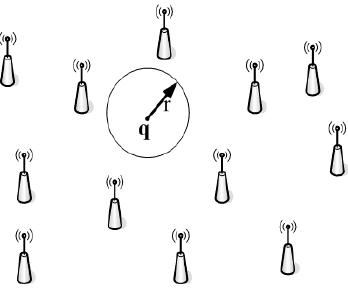
f for Poisson point a